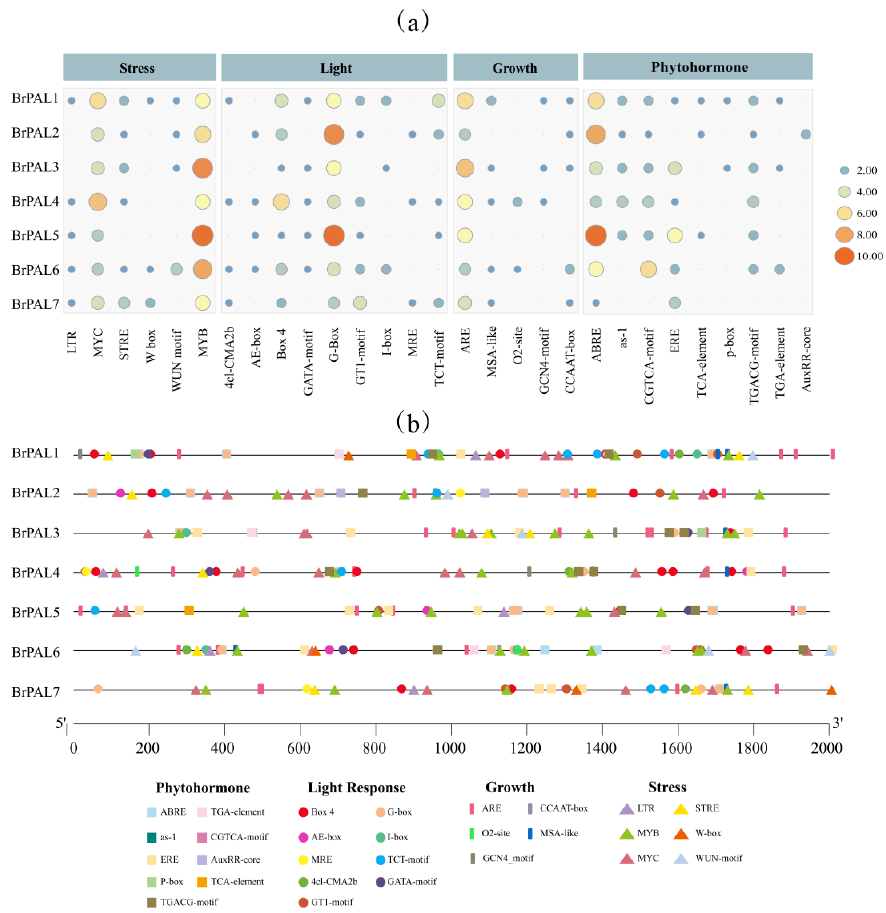
Figure 6. Prediction of cis-acting elements in the BrPAL promoter. ( a ) Each BrPAL promoter contains the number of detected cis-acting elements, classified into four types; ( b ) TBtools visualizes the hormone response elements in the BrPAL promoter, including the position of the element and the type.